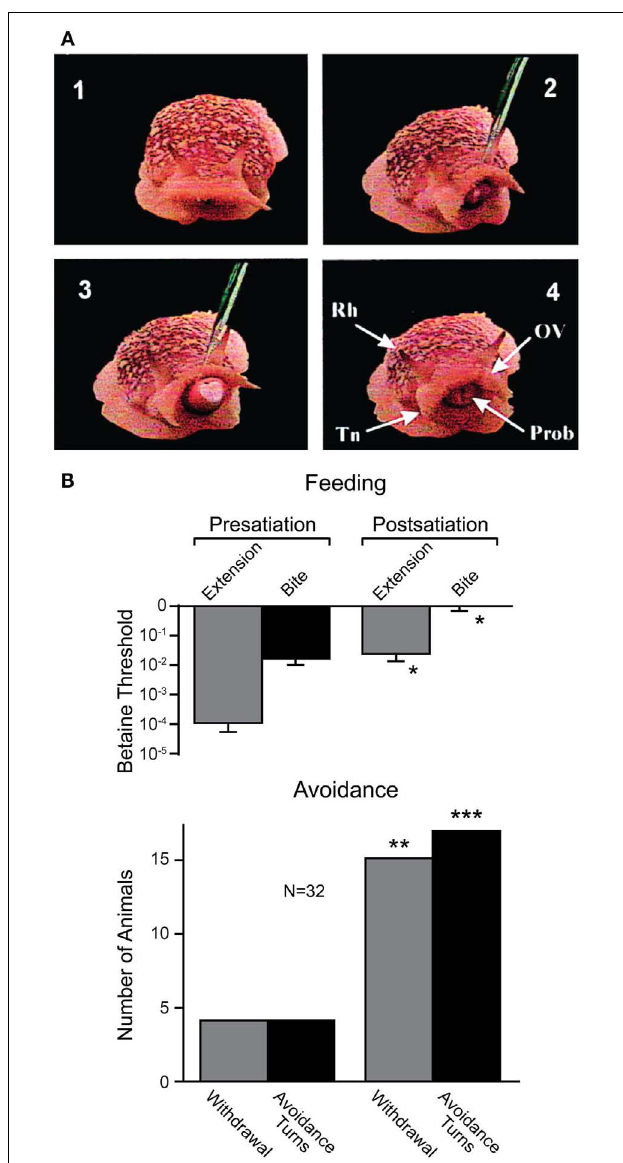
FIGURE 7 | Effects of internal state on behavioral choice in a sea slug. (A) Four video frames showing feeding behavior in Pleurobranchaea californica . Betaine application induces an orienting turn (panel 2) followed by proboscis extension and biting (panel 3). Chemosensory structures (panel 4): rhinophore (Rh), oral veil (OV), tentacle (Tn), and proboscis (Prob). (B) Partial satiation raised the threshold for proboscis extension and biting (i.e., feeding), and increased the frequency of withdrawal and turns (i.e., avoidance) in response to betaine. Modified from Gillette et al.